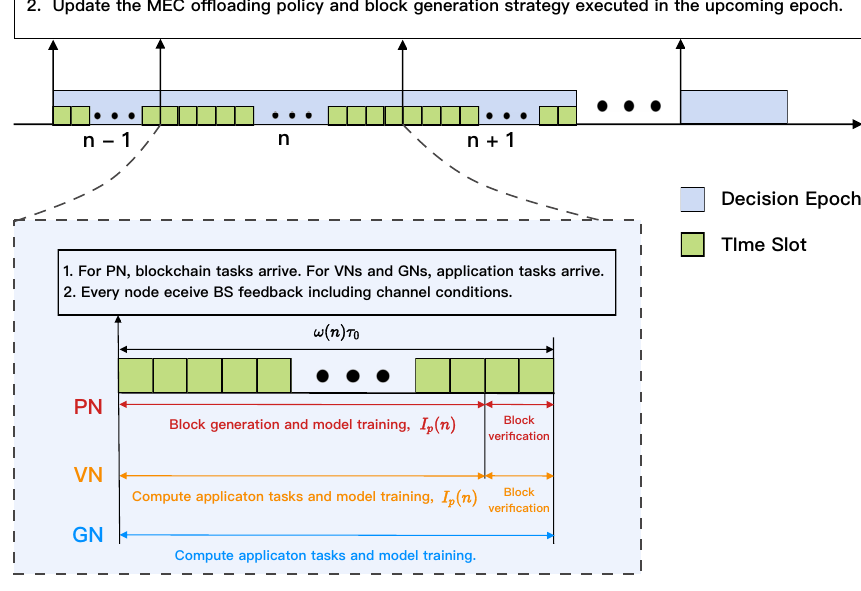
Figure 3. The relationship between time slot τ and decision epoch n